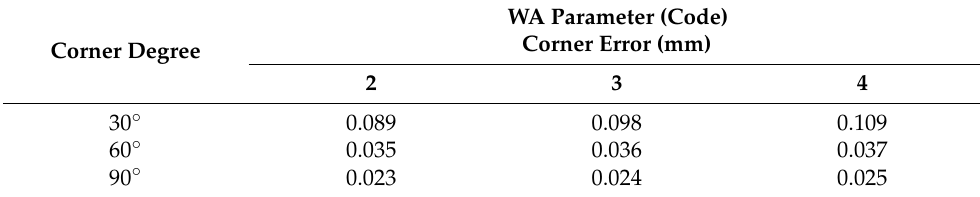
Table 11. Flushing pressure (WA) vs. corner